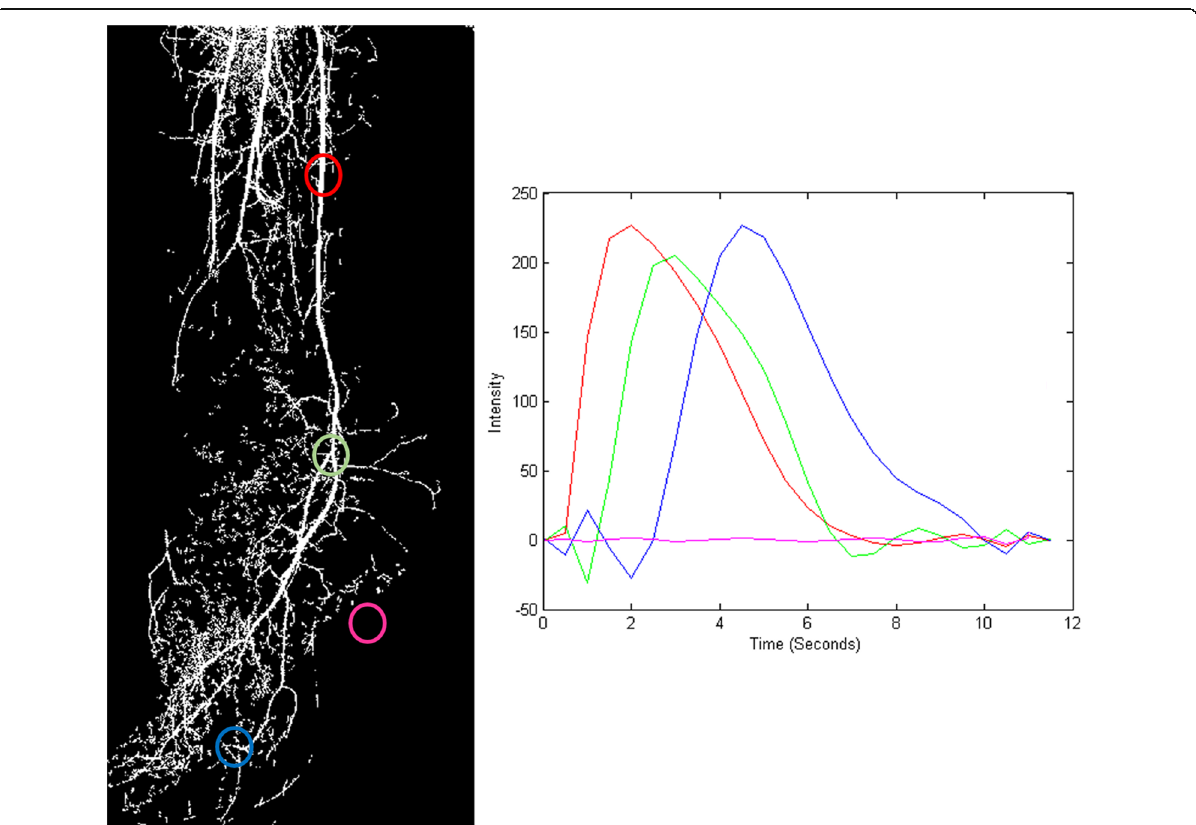
Fig. 4 Time-intensity curve calculation in masked concentration slices from various positions shown in red, green, blue, and pink. The perfusion blood volume and mean transit time maps were then used for perfusion blood volume map extraction according to Eq.